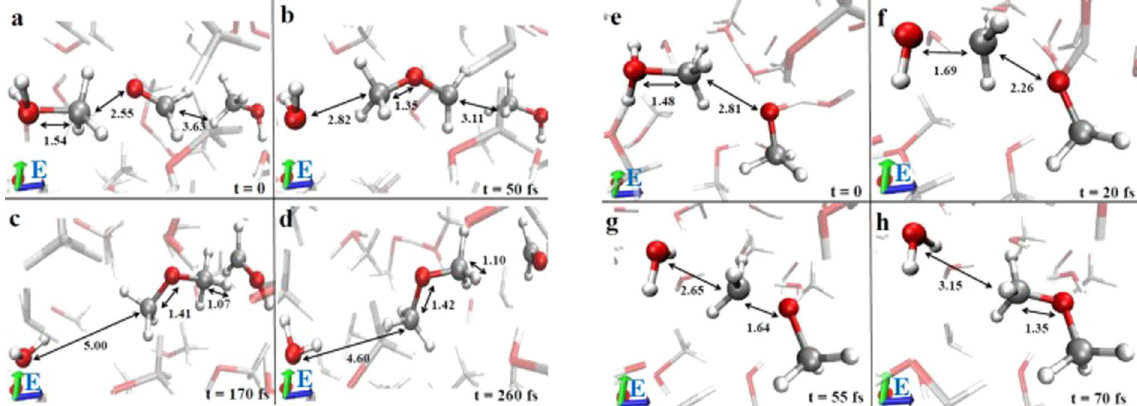
Figure 3. The least ( a – d ) and the most ( e – h ) favourable DME formation mechanisms in presence of a static electric field oriented along the positive z -axis ( i . e ., the blue cartesian axis direction) at a strength of 0.60 V/Å. Red, silver, and white coloring refers to oxygen, carbon, and hydrogen atoms, respectively. Several distances (shown in Å) have been chosen in order to better follow the reactions. ( a – d ) Starting from a methanol cation, a formaldehyde and a nearby methanol molecules ( a ), a water molecule and a DME cation are formed by transferring a methenium CH 3 + ( b ). In 120 fs the DME cation is neutralized thanks to an hydride H − stemming from the nearby methanol’s methyl group ( c ). Deprotonation of this latter species leads to the formation of another formaldehyde molecule along with DME and water ( d ). ( e – h ) A proton transfer event ( e ), assisted by the presence of a nearby methoxide anion, leads to the cleavage of the C-O bond of the newly formed CH 3 OH 2 + cation ( f ) ( i . e ., the bond length evolves from 1.48 Å to 1.69 Å in 20 fs). Local electrostatic effects produce thus the fast release of the methenium ion CH 3 + that, just after the “umbrella inversion” ( g ), recombines with the methoxide leading to the formation of DME and to the release of water ( h